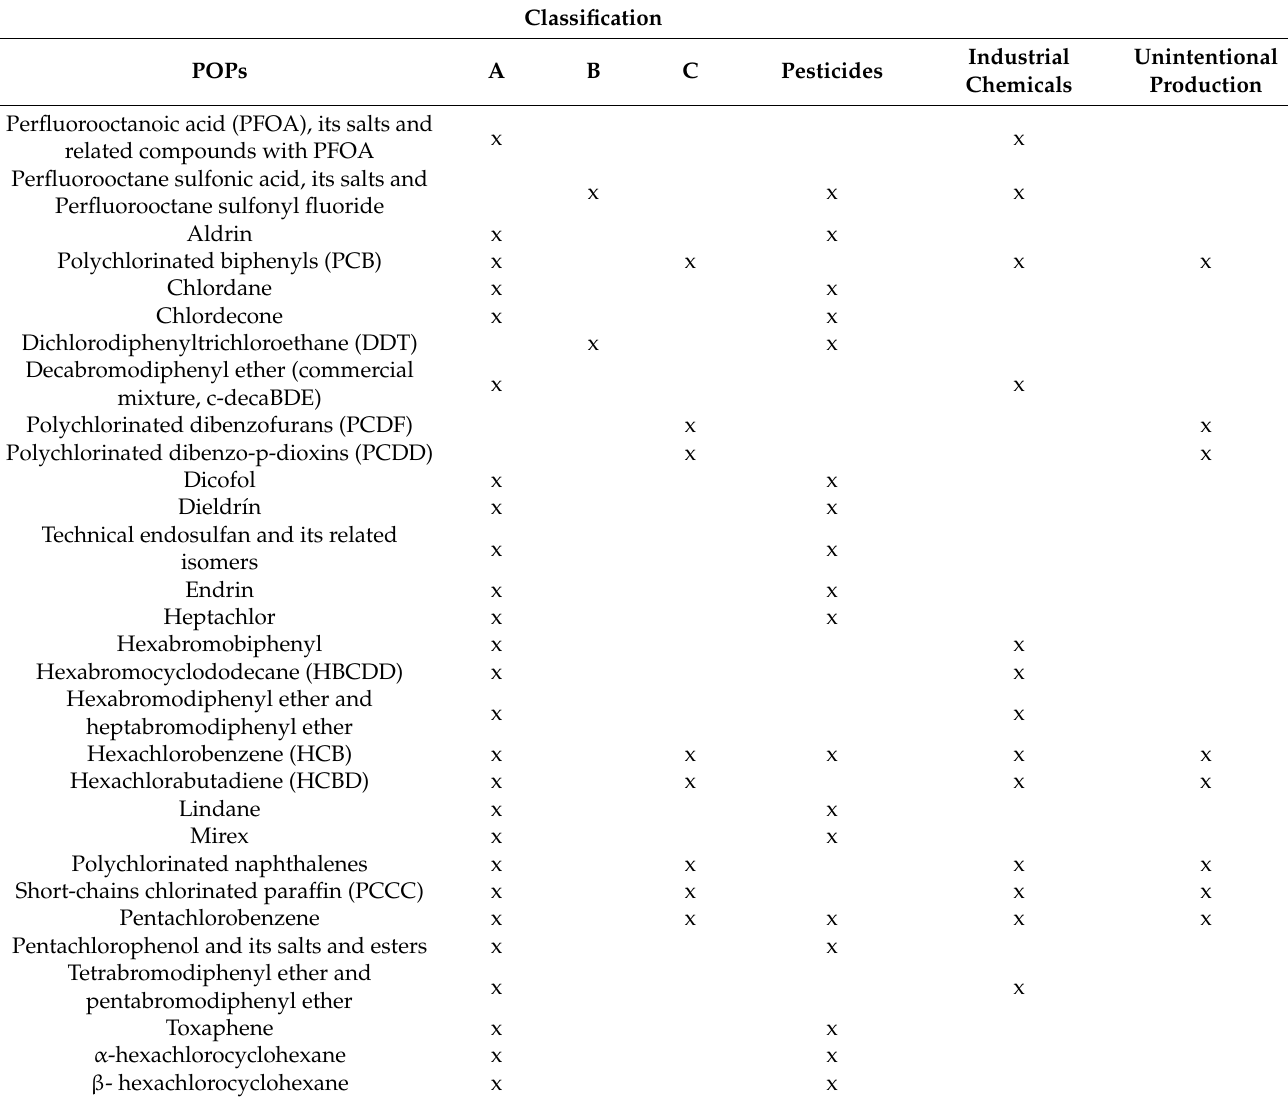
Table 1. POPs considered in the Stockholm